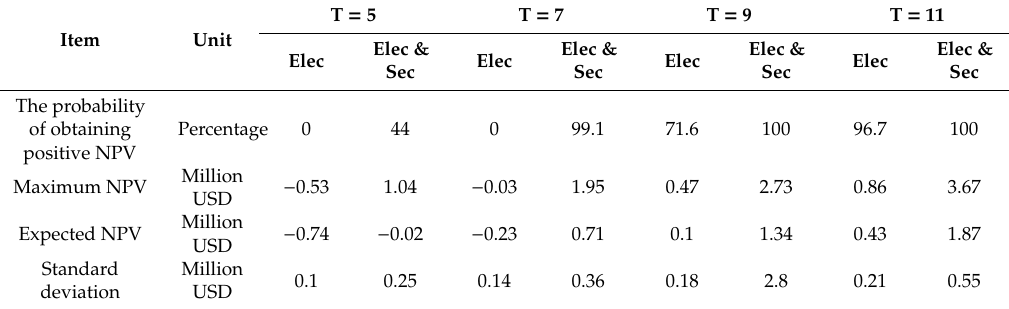
Table 5. The quantities of the statistical and probabilistic criteria.